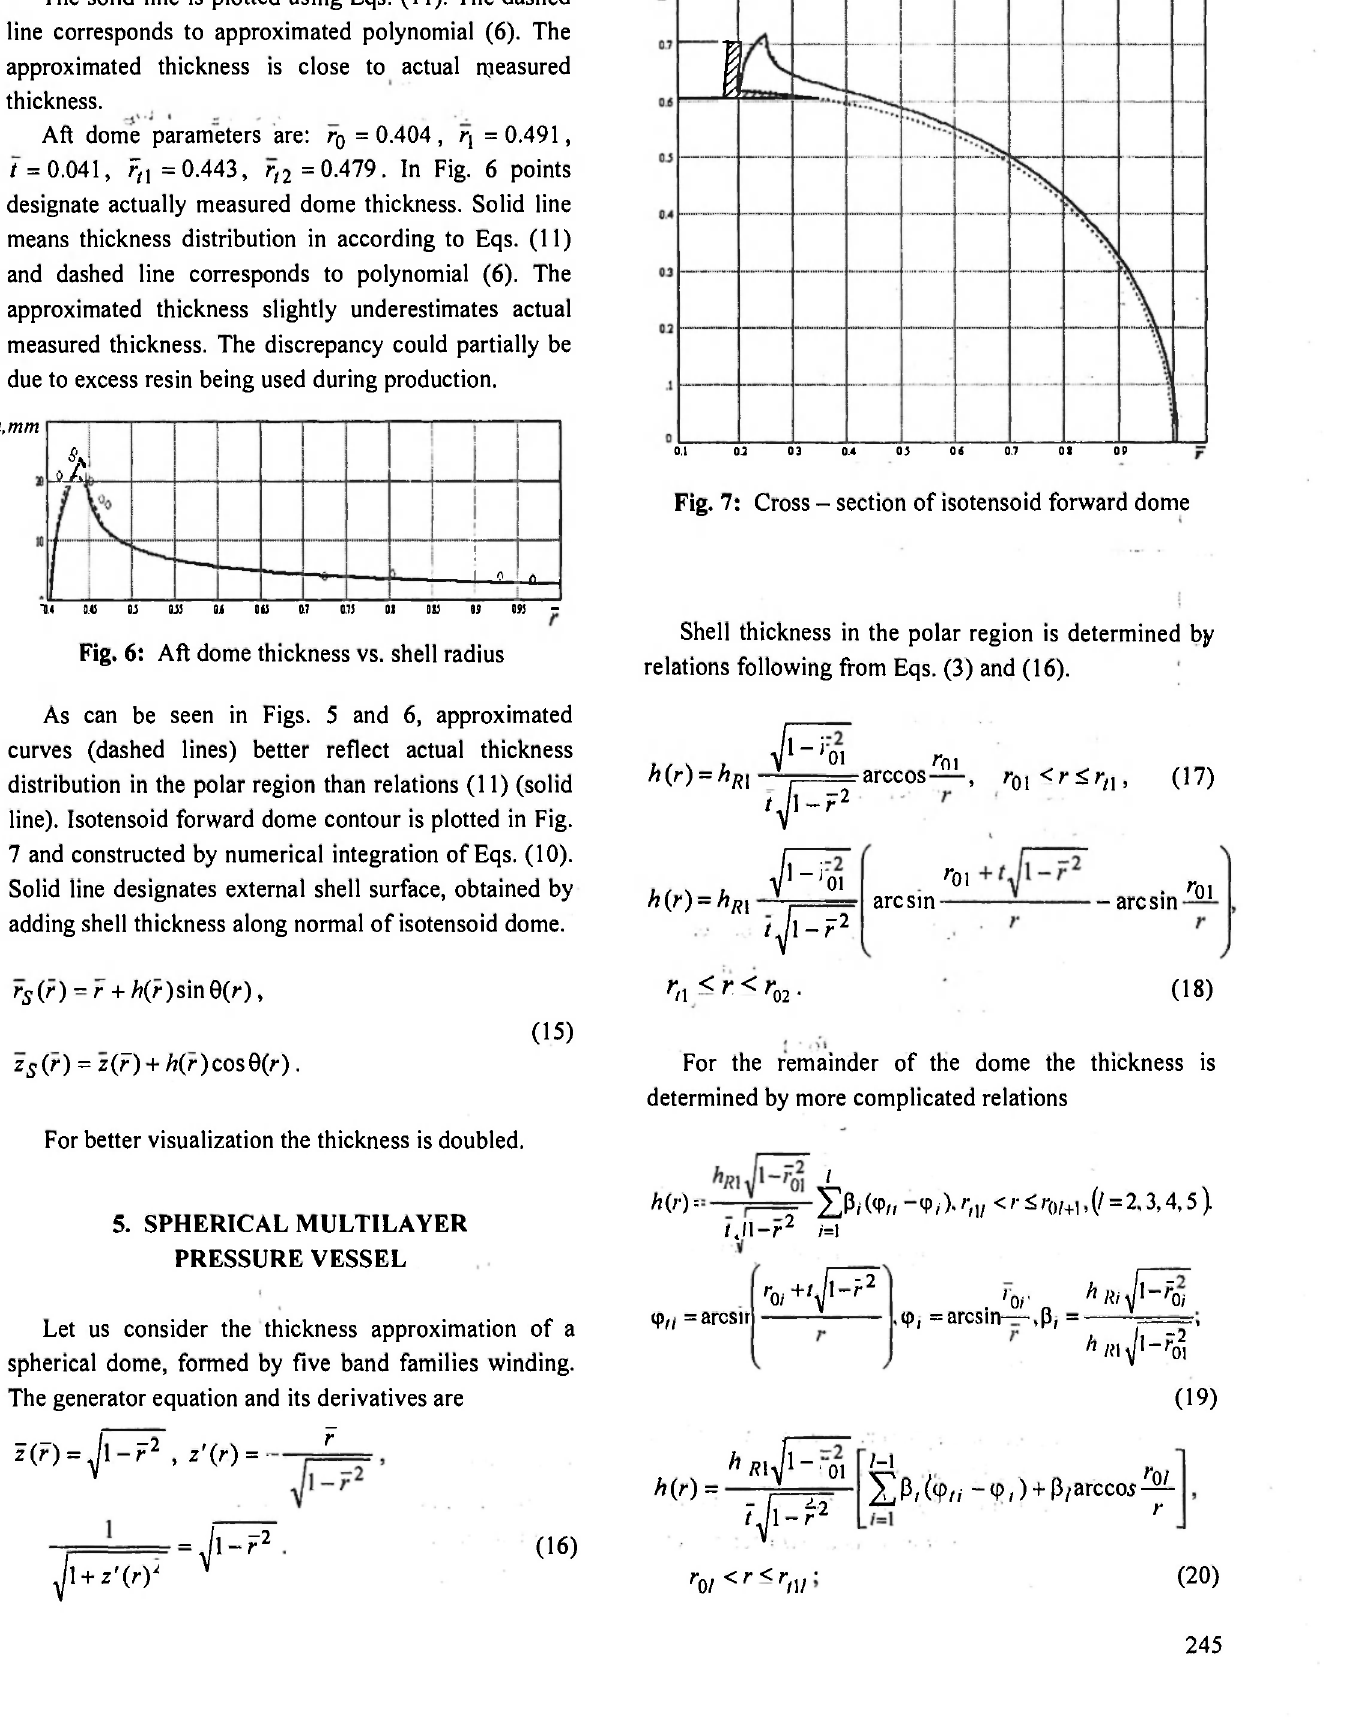
Fig. 6: Aft dome thickness vs. shell radius